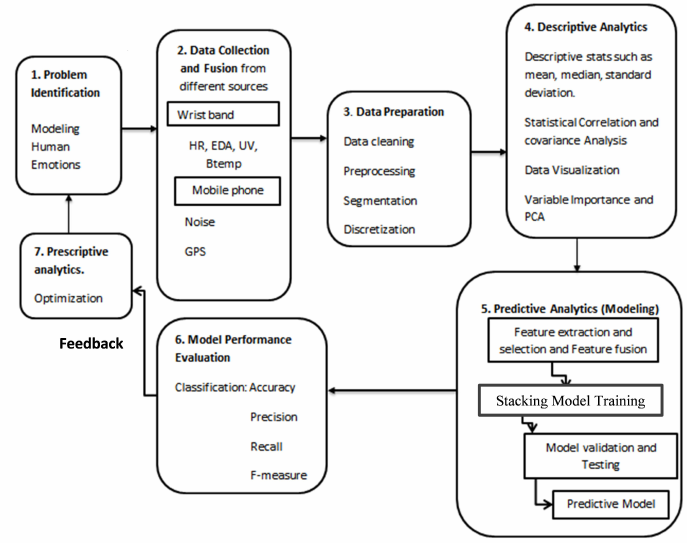
Figure 1. The proposed system architecture using data